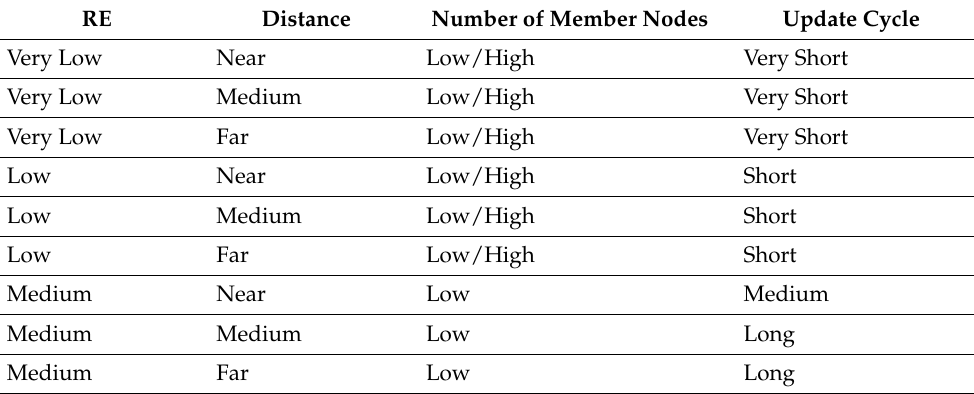
Table 1. A subset of fuzzy rules for determining the update